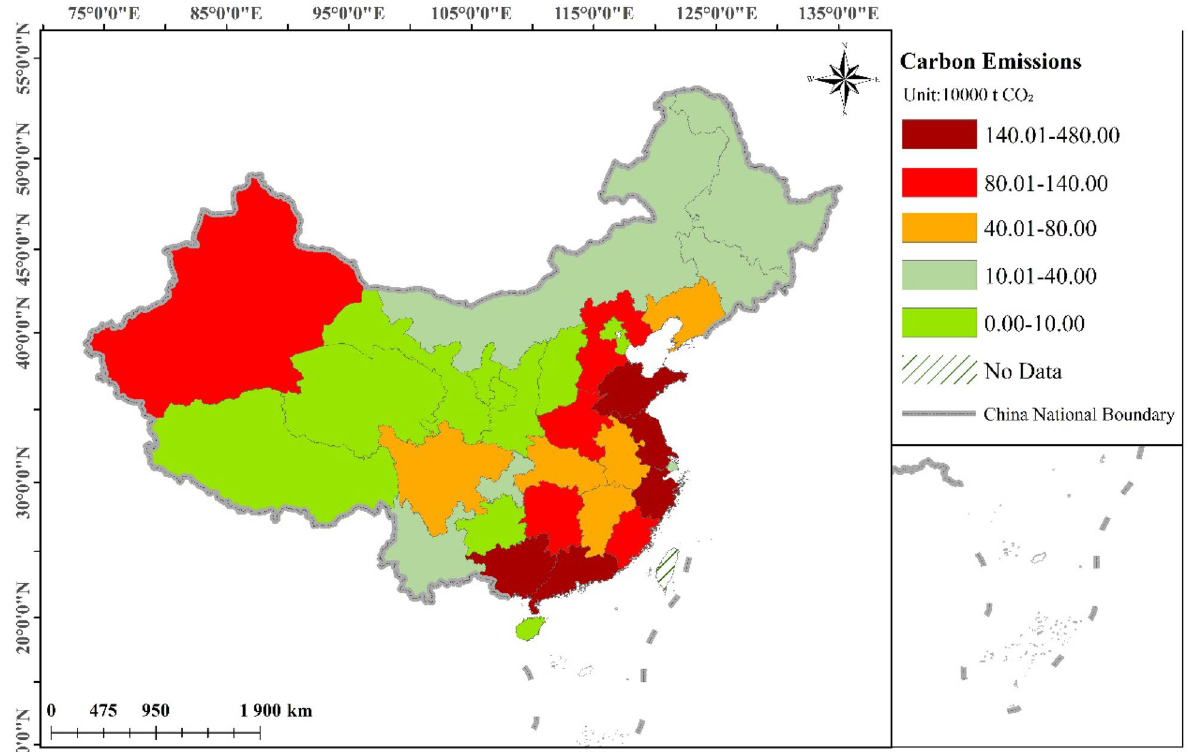
Fig. 6 Spatial distribution pattern of CO 2 emissions of China’s wood and bamboo processing industry in